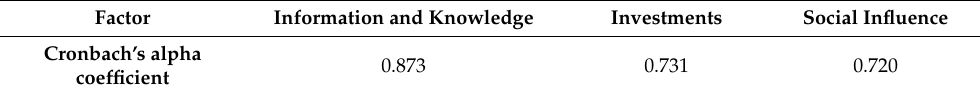
Table 3. Results of Reliability Analysis.